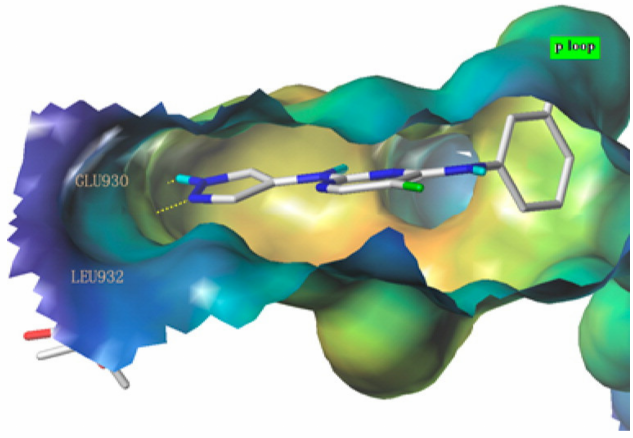
Figure 45. Docking of compound 40 with JAK2 crystal structure